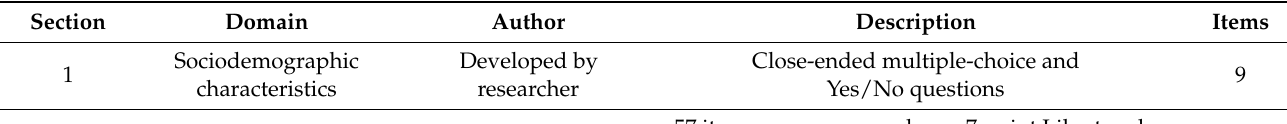
Table 1. Structure of research